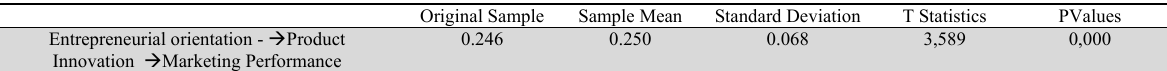
Indirect Effect test